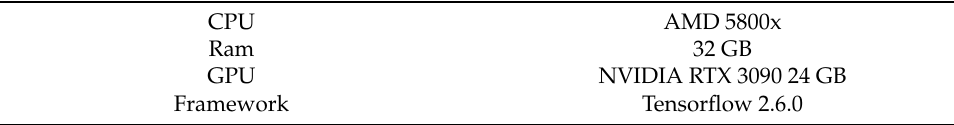
Table 4. Hardware Specification and Deep Learning